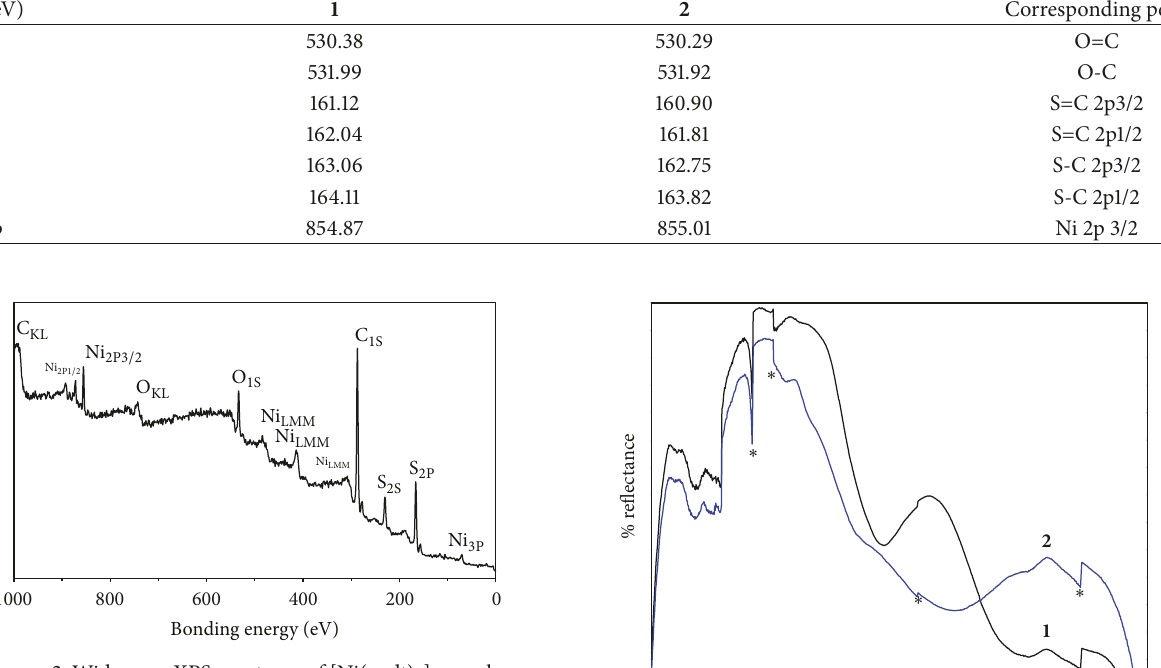
Figure 2: Wide-scan XPS spectrum of [Ni(cpdt) 2 ] complex.